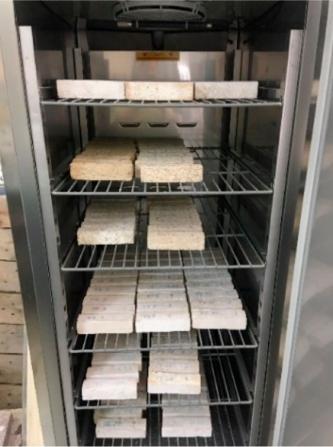
Figure 4. Samples during the wetting–drying cycles in the curing